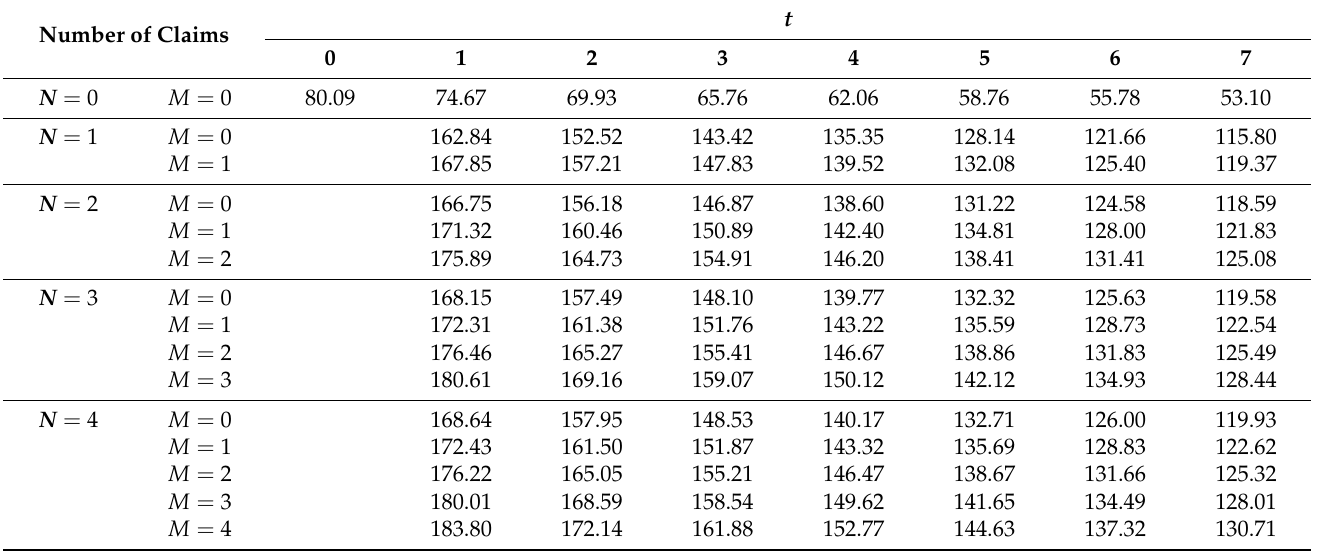
Table 9. Bonus-malus premiums based on Poisson binomial-exponential beta distribution for the frequency component and gamma-Lindley distribution for the severity component with a total claim size of S = 1500.